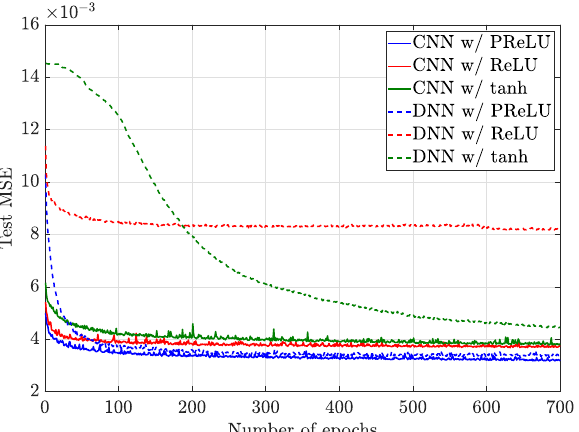
Figure 3. The test mean squared error (MSE) over epochs. The convolutional neural network (CNN)-based first-stage network and the deep neural network (DNN)-based first-stage network are compared, and three types of activation functions—PReLU, ReLU, and tanh—are used.